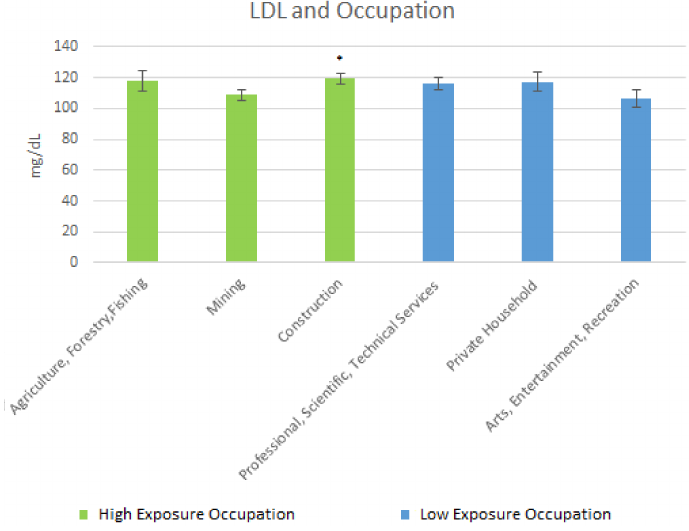
Figure 6. Occupation and LDL Levels. * Moderately significant difference between Construction and Arts, Entertainment, Recreation.